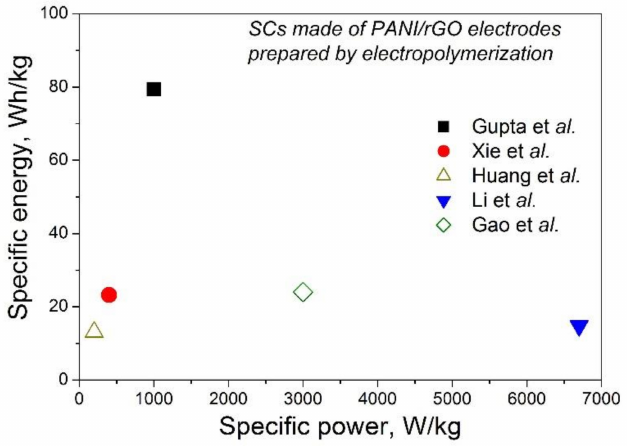
Figure 11. Available values of the specific energy and specific power of supercapacitors prepared using PANI/rGO electrodes from the publications of Xie et al. [51], Huang et al. [53], Gao et al. [56], Liu et al. [57] and Gupta et al.